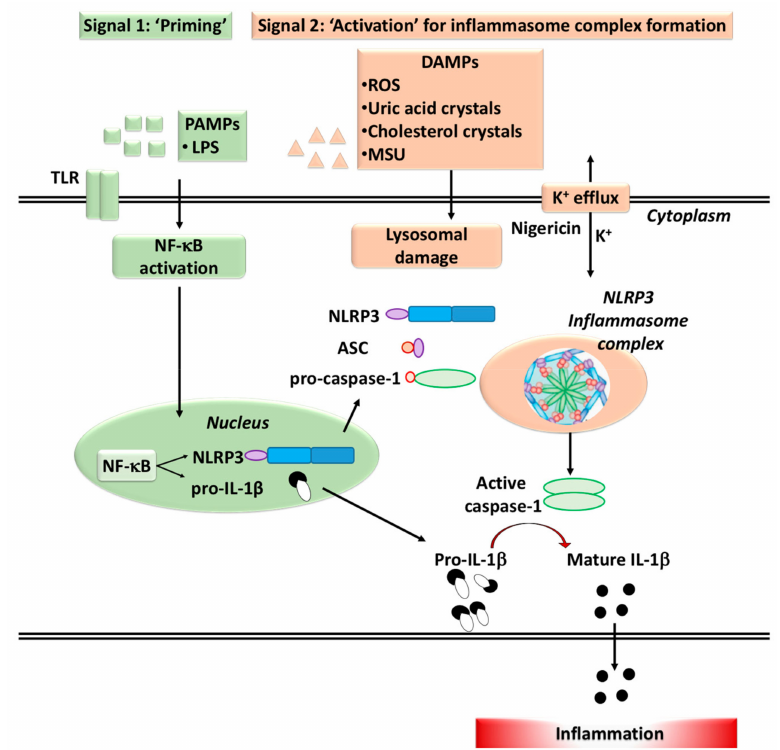
Figure 2. Activation and formation of inflammasome complex. Two-step signaling mechanisms are involved in the formation inflammasome complexes: The first “priming” signal initiated by infectious agents such as LPS, enhances the expression of inflammasome components and target proteins via activation of transcription factor NF- κ B. The second “activation” signal promotes the assembly of inflammasome components. The second signal also involves three major mechanisms, including lysosomal damage, and the potassium e ffl ux. Nigericin is a microbial toxin that alters potassium e ffl ux. Abbreviations: LPS: Lipopolysaccharide; TLR: Toll-like receptor; PAMPs: Pathogen-associated molecular patterns; DAMPs: Danger-associated molecular patterns; ROS: Reactive oxygen